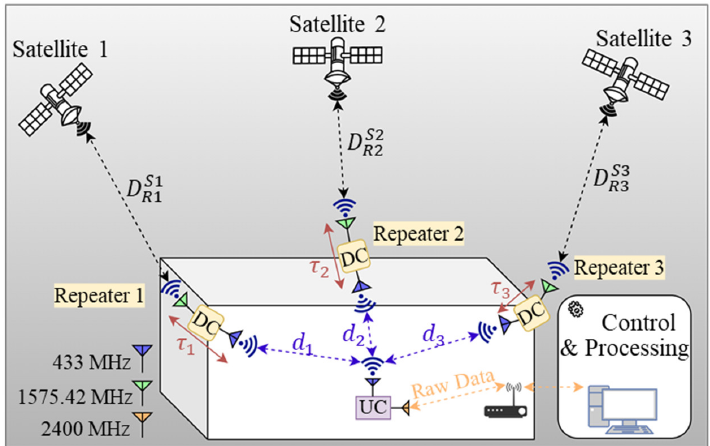
Figure 2. The proposed indoor positioning system. i: index of the repeaters ( i = 1, 2, 3); j : index of the satellites ( j = 1, 2, . . . , n ); Ri : i th repeater; Sj : j th satellite; d i : indoor distance from repeater Ri to the receiver (with a clock bias of t receiver ); D Sj : distance from ith repeater ( Ri :) to the j th satellite ( Sj ); τ i : propagation delay of the i th repeater; t Sj : satellite clock bias of the j th